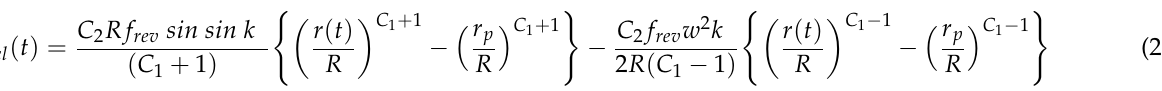
Figure 1. Schematic illustration of the drilling operation highlighting the three drilling stages. From which, the closed form solution for the force can be obtained as a function of the cutting time of stage I as shown in Equation